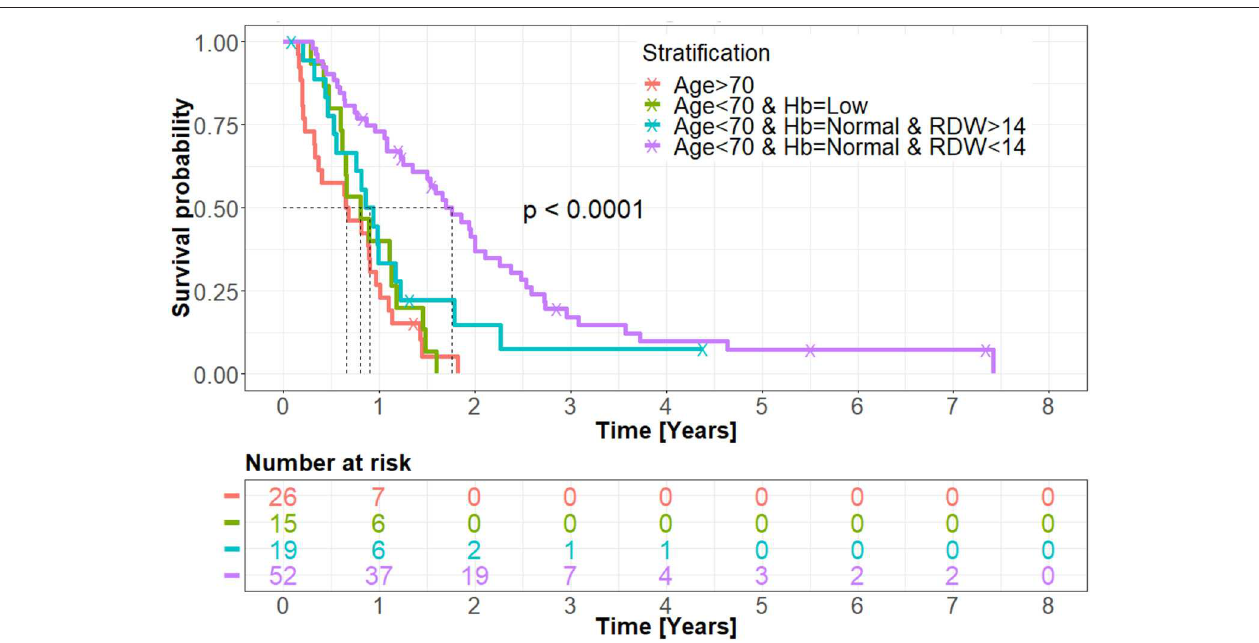
FIGURE 2 | Kaplan-Meir overall survival curve of the treated group. Patients whose age was over 70 and patients whose age was under 70 but with low hemoglobin level demonstrated the worst prognosis of the entire treated cohort. According to the data analysis, these patients did not survive past the first year following GBM diagnosis. Patients whose age was under 70 with a normal hemoglobin level but with RDW > 14% showed a slight trend toward improved overall survival, though not statistically significant. Patients whose age was under 70, with normal hemoglobin level and RDW < 14%, exhibited the best cohort overall survival, with long-term survival patterns demonstrated. Hb, hemoglobin; RDW, red blood cell distribution